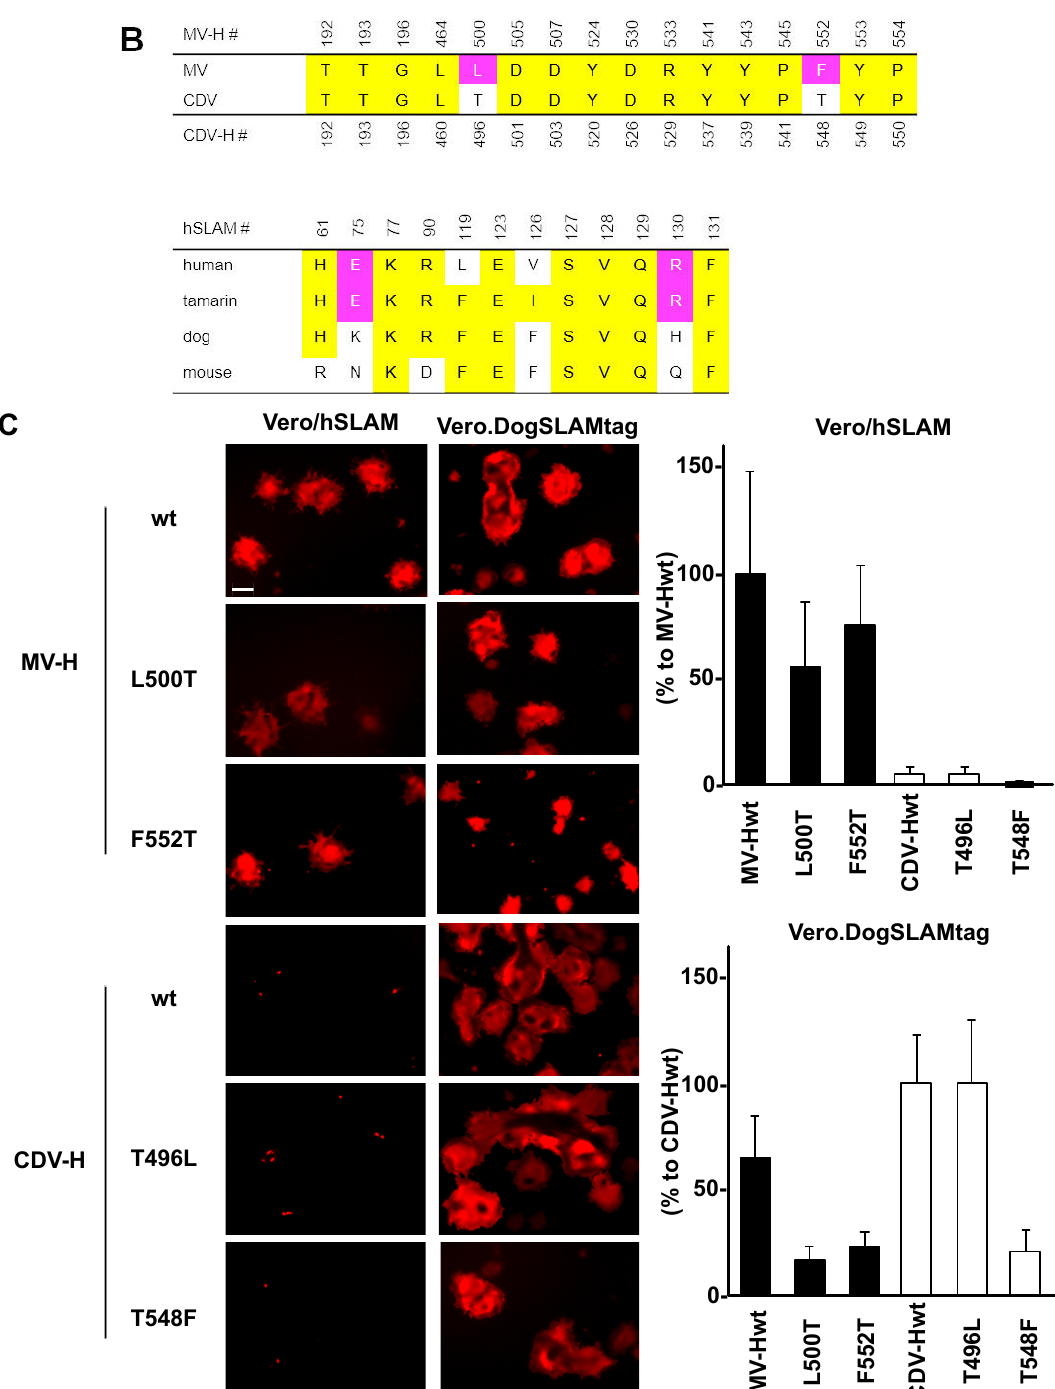
Figure 4. Conservation of H protein and SLAM interacting amino acid residues. ( A ) Mapping of conserved amino acids at the binding interface onto the crystal structure of the MV-Hvac monomer (light gray) in complex with tamarin SLAM (cyan) (Protein Data Bank (PDB) ID: 3ALW). Interacting amino acid residues are shown as yellow (conserved) or magenta (non-conserved) stick models. ( B ) Amino acid sequence alignments of the interacting residues, colored in the same way as Figure 4A. ( C ) Fusion activities for MV- and CDV-H mutants toward hSLAM and dSLAM. All figures are in the same scale and the white bar indicates 200 µ m. The fused cell areas were measured using hybrid cell count software. The averaged values of MV-Hwt for Vero / hSLAM and CDV-Hwt for Vero.DogSLAMtag were set at